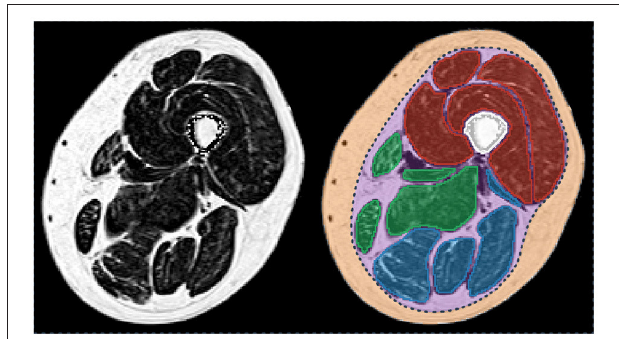
FIGURE 1 | Fat fraction map of a thigh of a patient with myotonic dystrophy type 1 (left) and corresponding segmentation of the principal regions of interest (right) . Femur is in white. The individual muscles of the knee extensors, knee flexors, and the medial compartment are in red, blue, and green, respectively. Subcutaneous (orange) and perimuscular (purple) tissues are separated by the fascia lata (dot line in dark blue). Patient participated in the randomized controlled trial OPTIMISTIC (